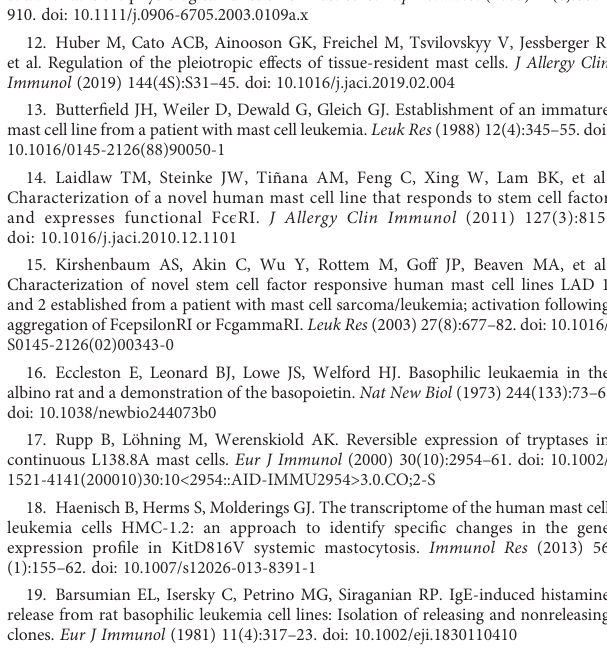
cultivated either under reduced (blue) or full medium (red) conditions. The upper two panels show frequency distributions relative to an unstained control (grey) while the lower panel shows frequency distribution comparing reduced and full medium conditions. (K) Quanti fi cation of the FACS surface marker analysis depicted in (J) with MFIs showing staining intensities for the respective surface markers as well as FSC and SSC parameters (n=3). (A – I) One-way ANOVA followed by Dunnett multiple comparisons test. (K) Unpaired, two-tailed Student ’ s t -test with Welsh ’ s correction. Data are expressed as mean +SD. p >0.05 ns, * p <0.05, ** p <0.01, *** p <0.001, **** p <0.0001. SUPPLEMENTARY FIGURE 5 Cytogenetic and gene expression analysis of the independently transformed PMC cell line PMC-303. (A) Table of all discovered cytogenetic aberrations of mitotic chromosomes of the PMC-306 cell line with associated frequencies. (B) Representative G-banded karyotype of the PMC-303 cell line with trisomy 8 due to a homologous Robertsonian translocation of chromosome 8 (Rb (8.8)). (D – H) RT-qPCR analysis of genes encoded within in the region of chromosome 4, which is deleted in the PMC-306 cell line (Chr4 qC4-qC7). Gene expression of Cdkn2a , Arf , Rbl1 , Mllt3 , Dennd4c and Plaa were measured in PMC-303 cells in comparison to primary WT PMCs (n=3). Data are expressed as mean +SD. Unpaired, two-tailed Student ’ s t -test with Welsh ’ s correction. * p <0.05. SUPPLEMENTARY FIGURE 6 Characterization of the PMC-303 cell line. (A) Representative FACS histograms showing surface localization of Fc e RI, KIT, ST2 and CD13 in PMC-303 cells after freeze-thaw relative to an unstained control (n=3). (B) Representative electron micrographs showing the ultrastructure of PMC-303 cells. (C) Quanti fi cation of the relative b -hexosaminidase activity in lysates of primary PMCs and PMC-303 cells determined by an enzymatic assay to quantify the amount of cellular b -hexosaminidase expressed in primary PMCs and PMC-306 cells (n=3). (D) Determination of the degranulation of PMC- 303 cells in response to indicated concentrations of C48/80 assessed by b - hexosaminidase release assay (n=3). (E) Determination of the degranulation of PMC-303 cells in response to indicated concentrations of Mastoparan assessed by b -hexosaminidase release assay (n=3). (F) FACS analysis of PMC-